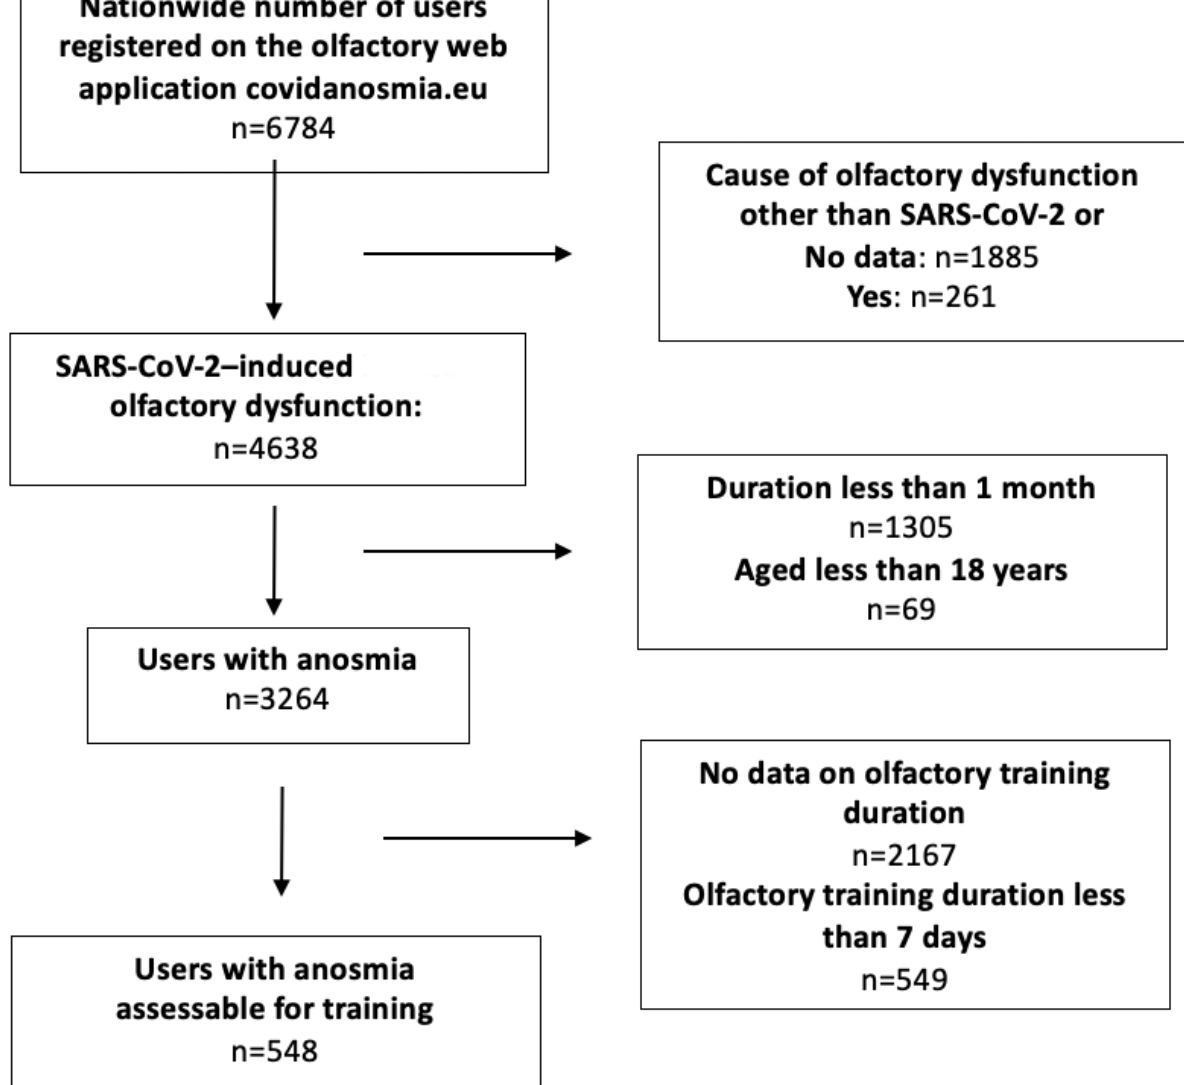
Figure 1. Flowchart of patients who used a web application for olfactory